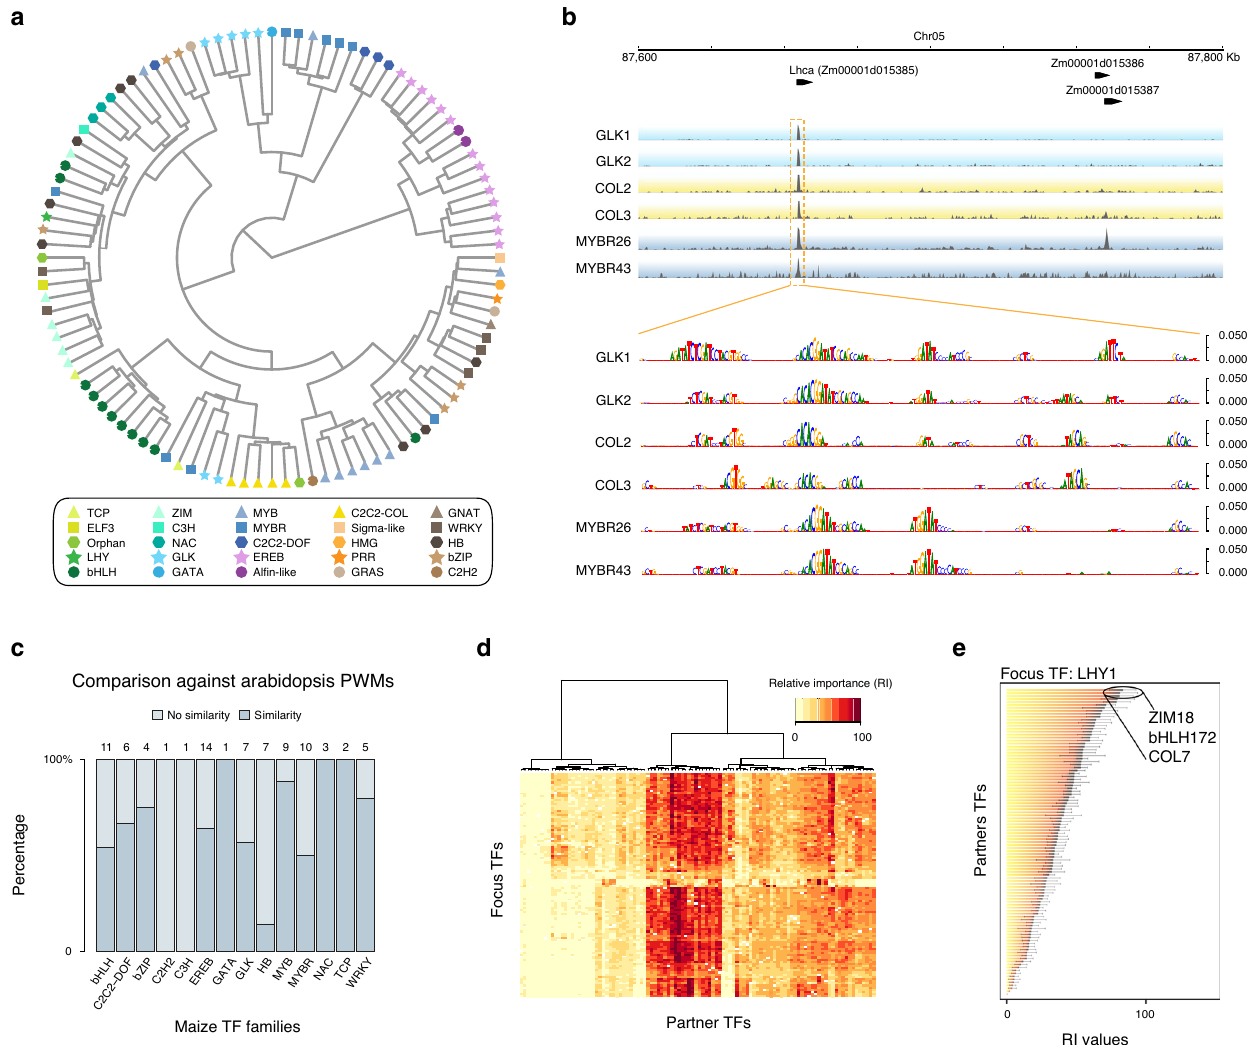
Fig. 6 Machine-learning models of TF recognition sequence and co-binding. a TFs clustered by sequence binding similarity (predicted k -mer weights) derived from the sequence models. b Example browser tracks showing the promoter region of Lhca , which encodes the light-harvesting complex of photosystem I. Occlusion analysis for TFs targeting Lhca promoter showing scores of putative regulatory positions at base pair resolution derived from the models. c Conservation of recognition sequence between Arabidopsis and maize TF homologs. Numbers of TFs examined are shown at the top, and the TF family names are shown at the bottom. d Cluster of 104 TFs based on their relative importance value with co-binding TFs. e Top three co-binding partner TFs of LHY1 based on RI ranking. Source data underlying Fig. 6c, d are provided as a Source Data fi